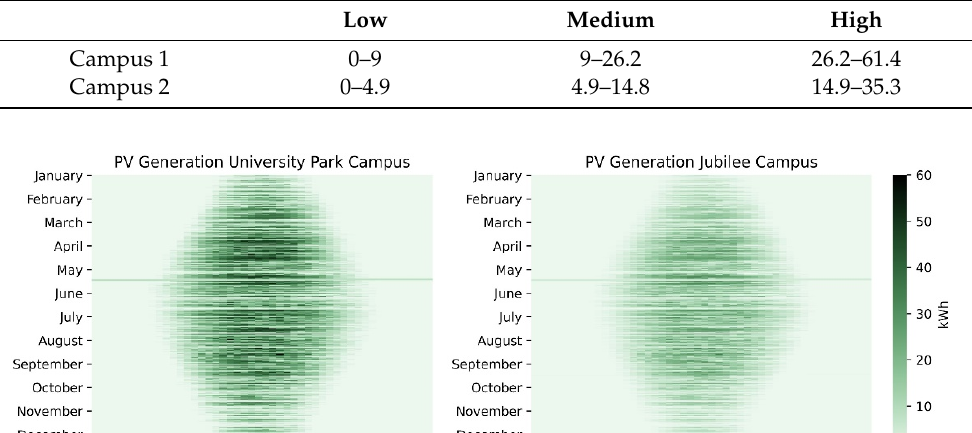
Table 9. Renewable energy generation thresholds (kWh per 30 min).